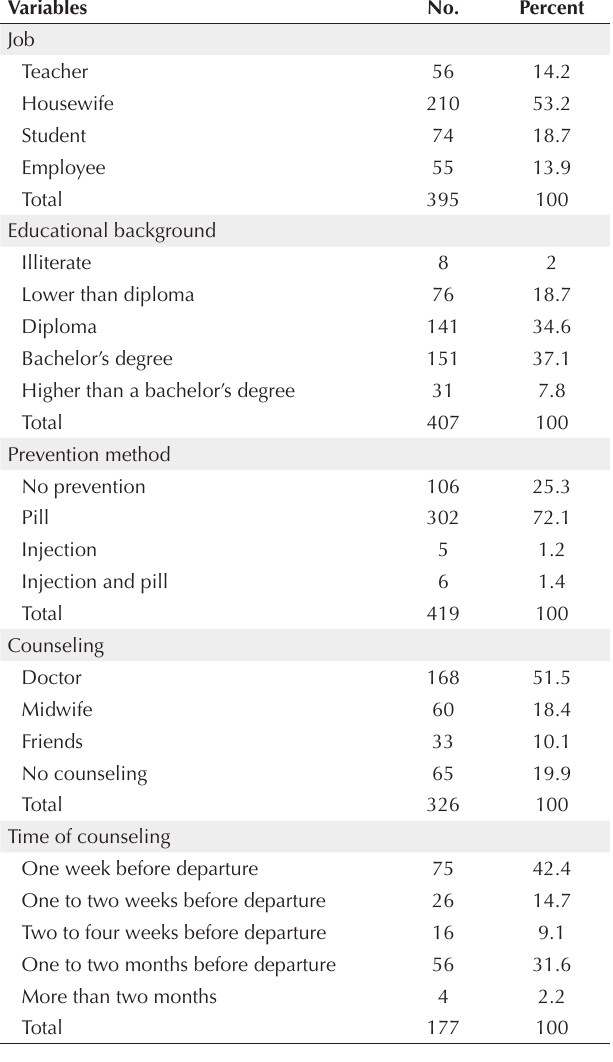
Table 1 . Sample Frequency in Terms of Job, Educational